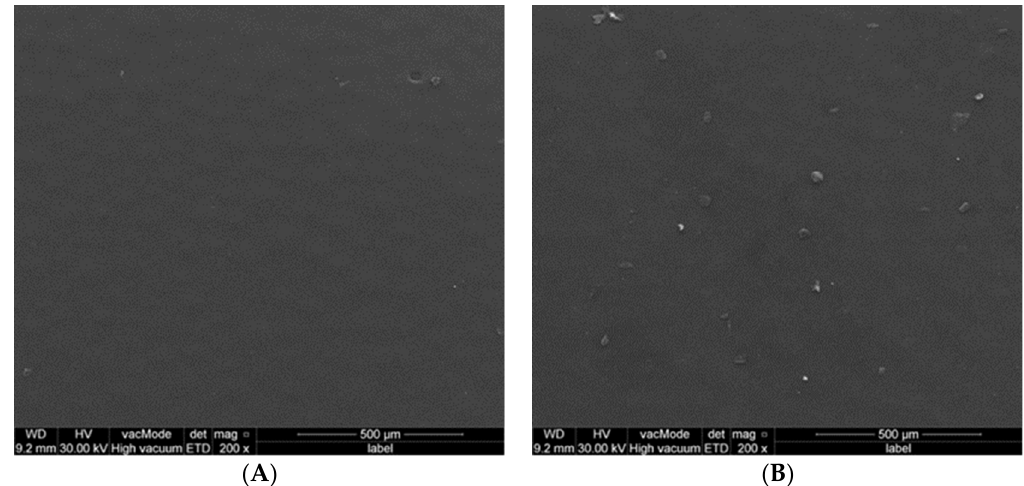
Figure 4. SEM for powder of control group, ( A ) PMMA powder alone; ( B ) PMMA powder with ethanol.